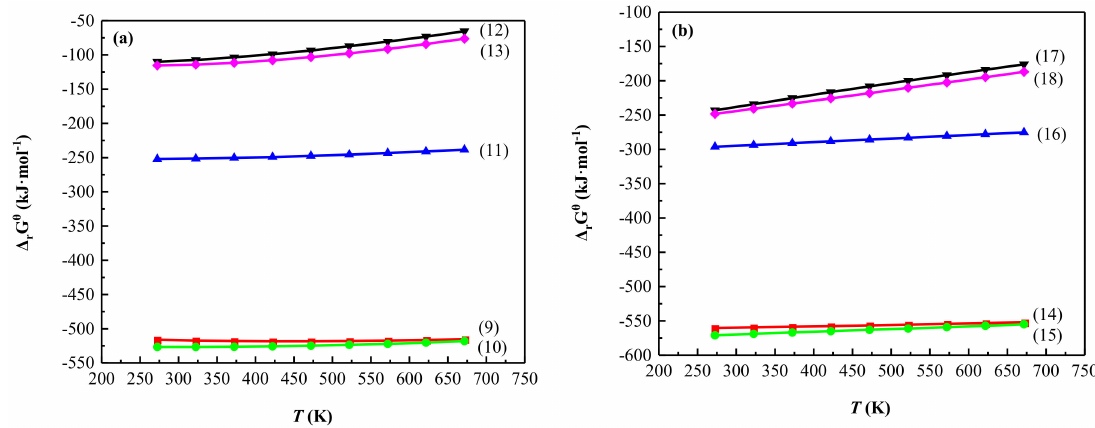
Figure 8. Correlation of standard Gibbs free energy ( ∆ r G θ ) with temperature for ( a ) reactions (9)–(13) and ( b ) reactions